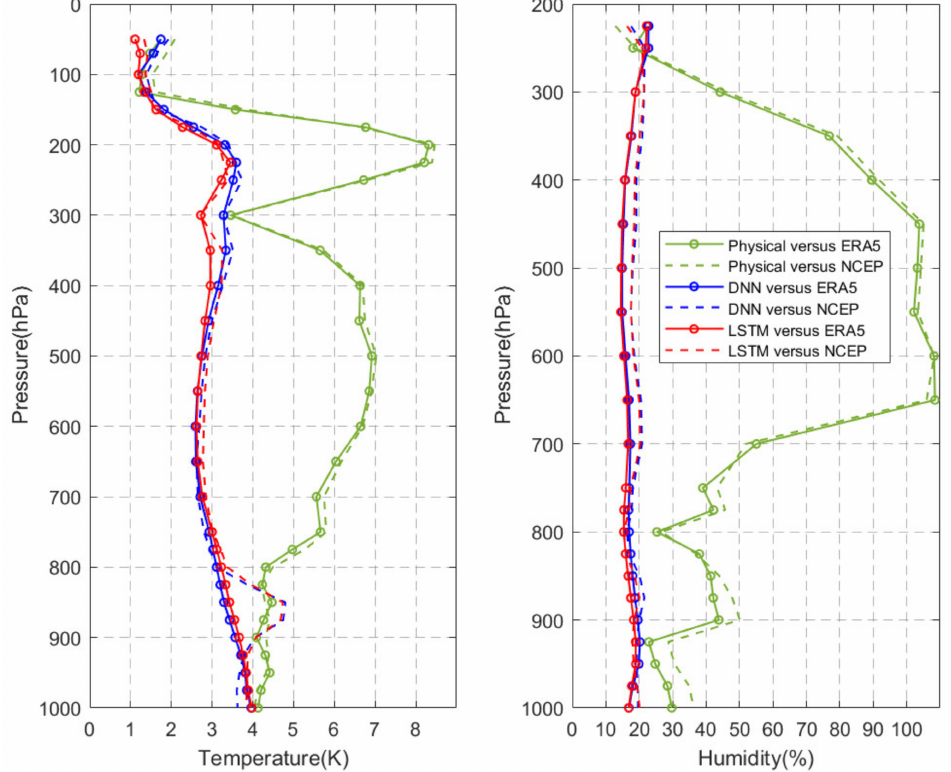
Figure 9. The retrieval RMSEs of the DNN model, the LSTM model, and the physical retrieval algorithm with respect to ERA5 and NCEP reanalysis data over land in June